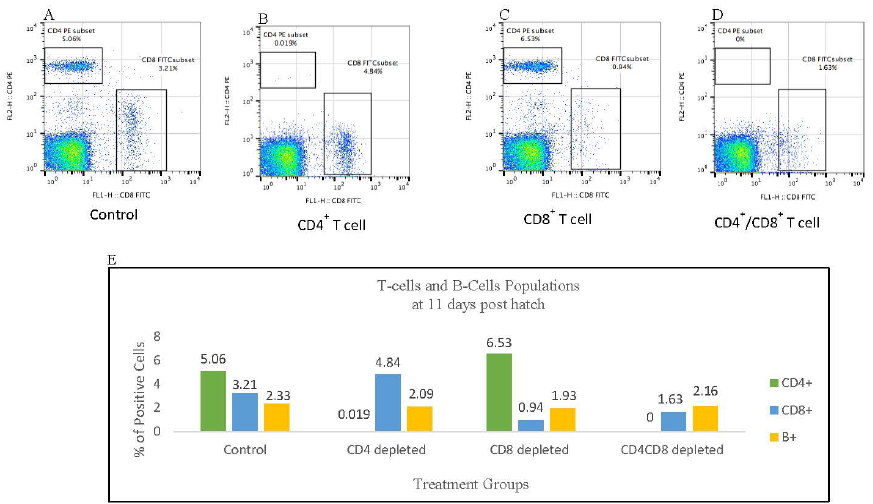
Figure 1. T Cells depletion. Flow cytograms show the percentage of CD4 + and CD8 + T Cells in the control ( Panel A ), CD4 + T Cell depleted birds ( Panel B ), CD8 + T Cell depleted birds ( Panel C ), and CD4 + /CD8 + T cell depleted birds ( Panel D ) 11 days post-treatment. Blood samples from three birds per group were pooled, PBMC isolated, and 1 × 10 6 cells/100 µ L was used for cell surface antigen analysis. The CD4 + T Cells were stained with CD4-PE, and CD8 + T Cells were stained with CD8 α